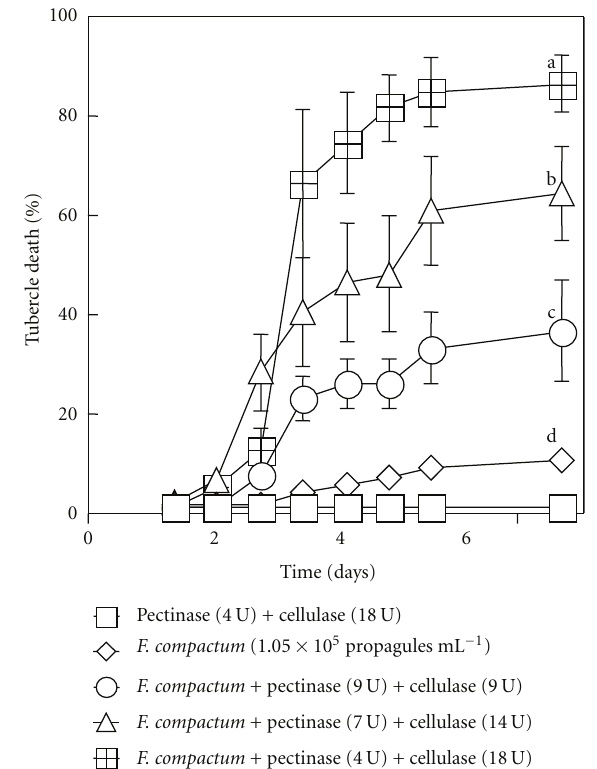
Figure 4: Strong increase in virulence stimulated by cellulase with some amount of pectinase when the fungus is at suboptimal levels. Roots of tomato plants infested with broomrape were sprayed with ♦ 1.05 × 10 5 propagulesml − 1 , plus ◦ 9U pectinase and 9 U cellulase, (cid:4) 7U pectinase and 14 U cellulase or (cid:5) 4U pectinase and 18 U cellulase per ml of homogenized mycelial suspension. The controls (cid:2) , which all gave the same response were water alone, and pectinase plus cellulase (4U:18 Uml − 1 ) aqueous solution